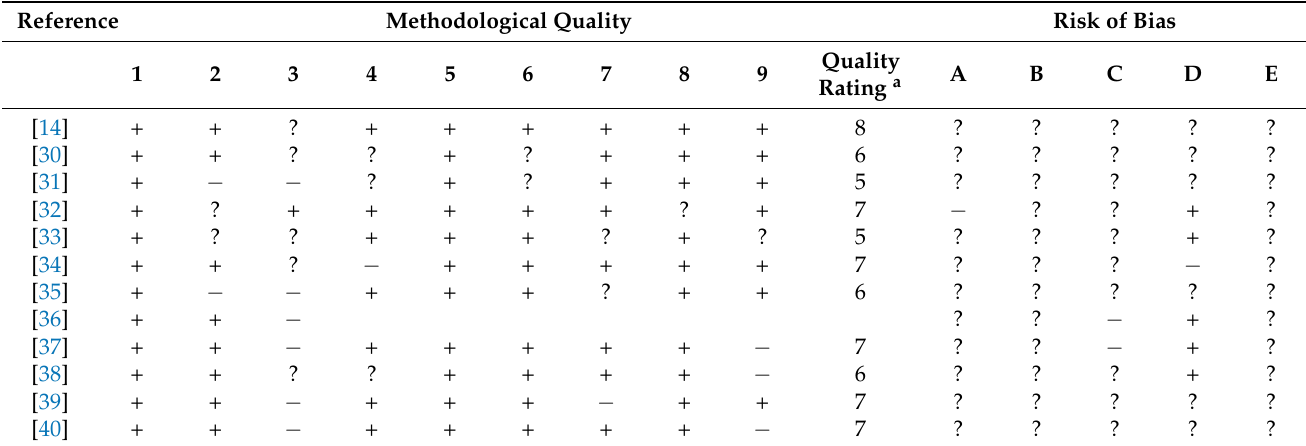
Table 1. Methodological quality and risk of bias of included studies.